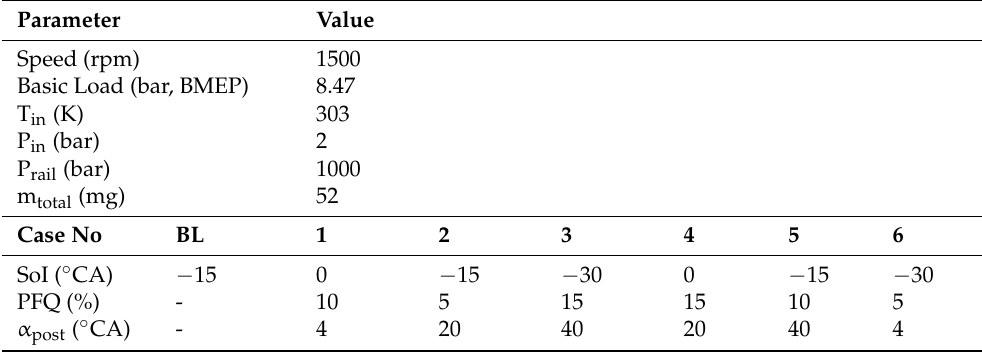
Table 2. Engine operating conditions for the post injection validation